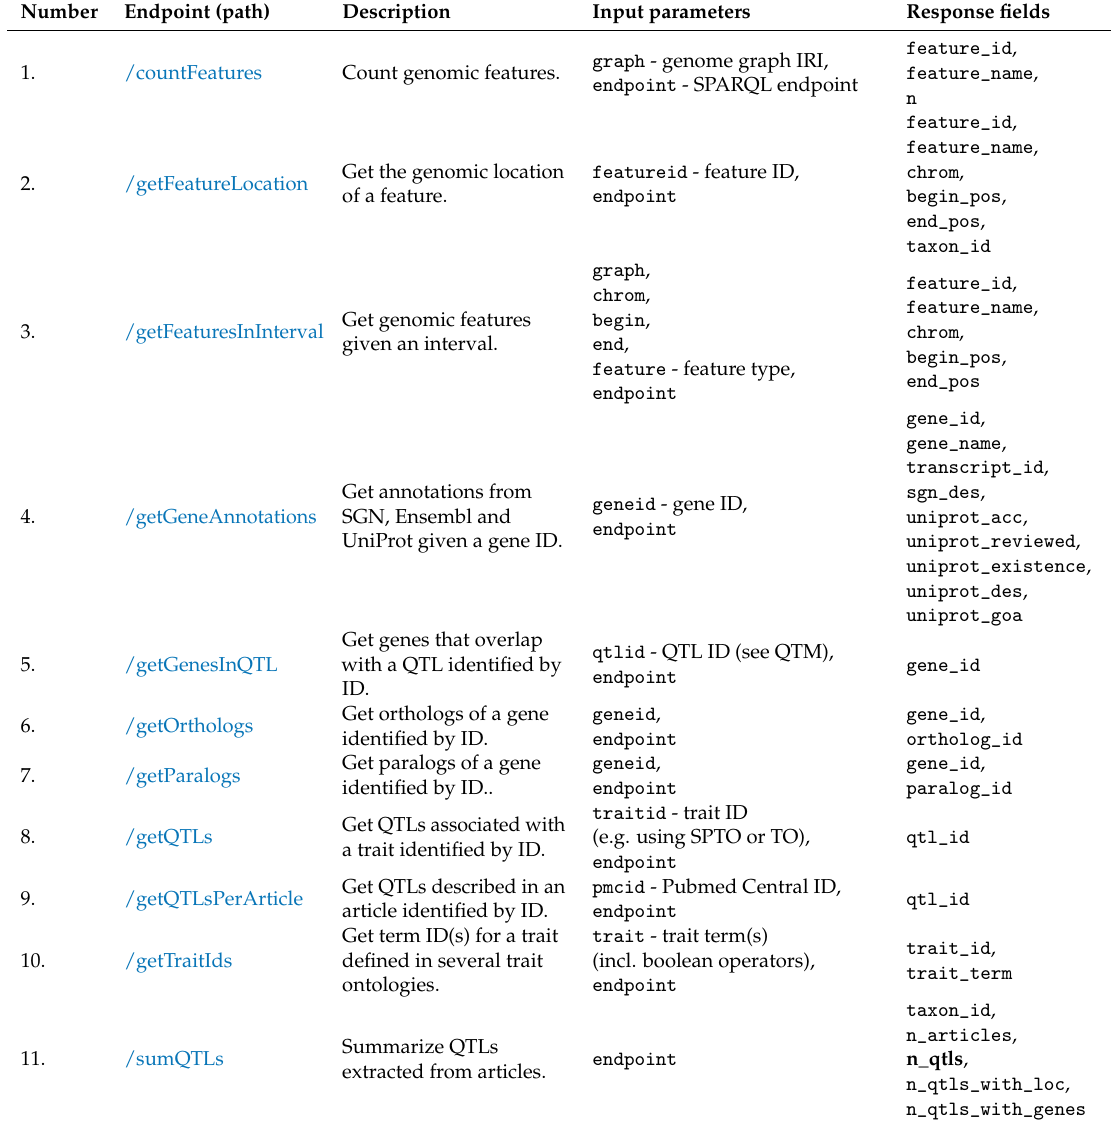
Table A1. List of RESTful API endpoints of pbg-ld generated by the grlc service (deployed on http://localhost:8088